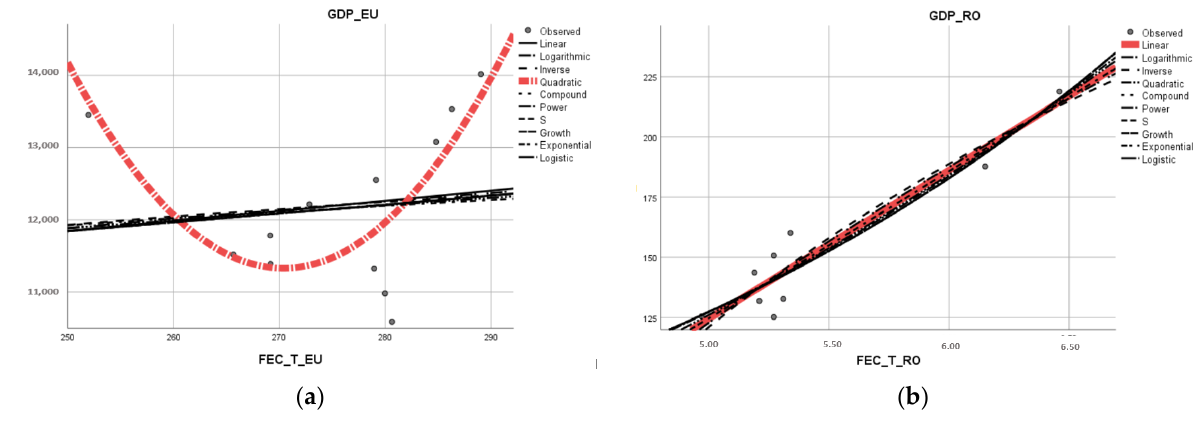
Figure 10. MLP network for identifying the influences of FEC_T on GDP: ( a ) EU; ( b ) RO.